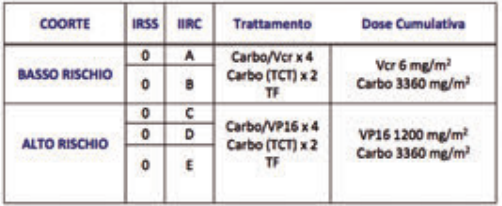
P012 OUTCOME OCULARE DEI PAZIENTI AFFETTI DA